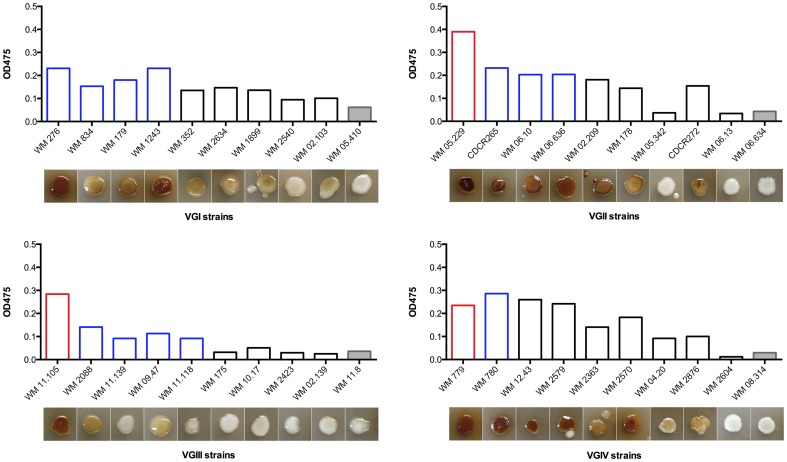
Melanin production of Cryptococcus gattii strains.Strains are grouped by major molecular type and distributed in the X-axis from more to less virulence. Line colour of the bars represents more virulent (red), similarly virulent (blue), and less virulent strains (black), compared with the highly virulent VGIIa Vancouver Island outbreak strain CDCR265. Grey bars represent avirulent strains. Both the quantification of the laccase activity and the ability of the strains to produce melanin in Niger seed agar are represented.